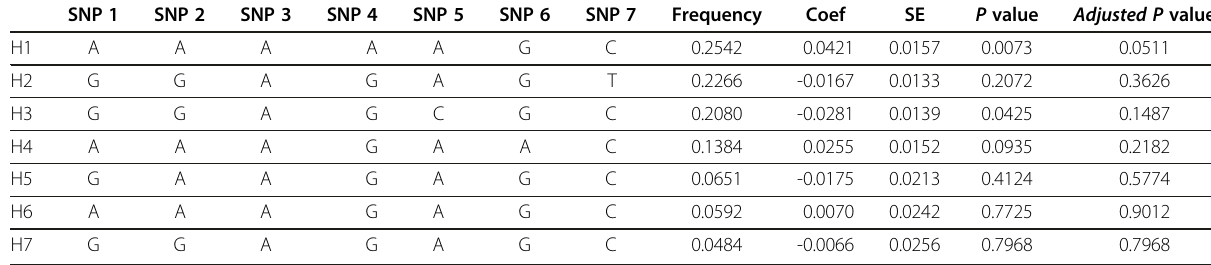
Table 5 Association of SELE locus haplotypes with sE-selectin level (adjusted for age, gender, BMI, smoking, sICAM1 and